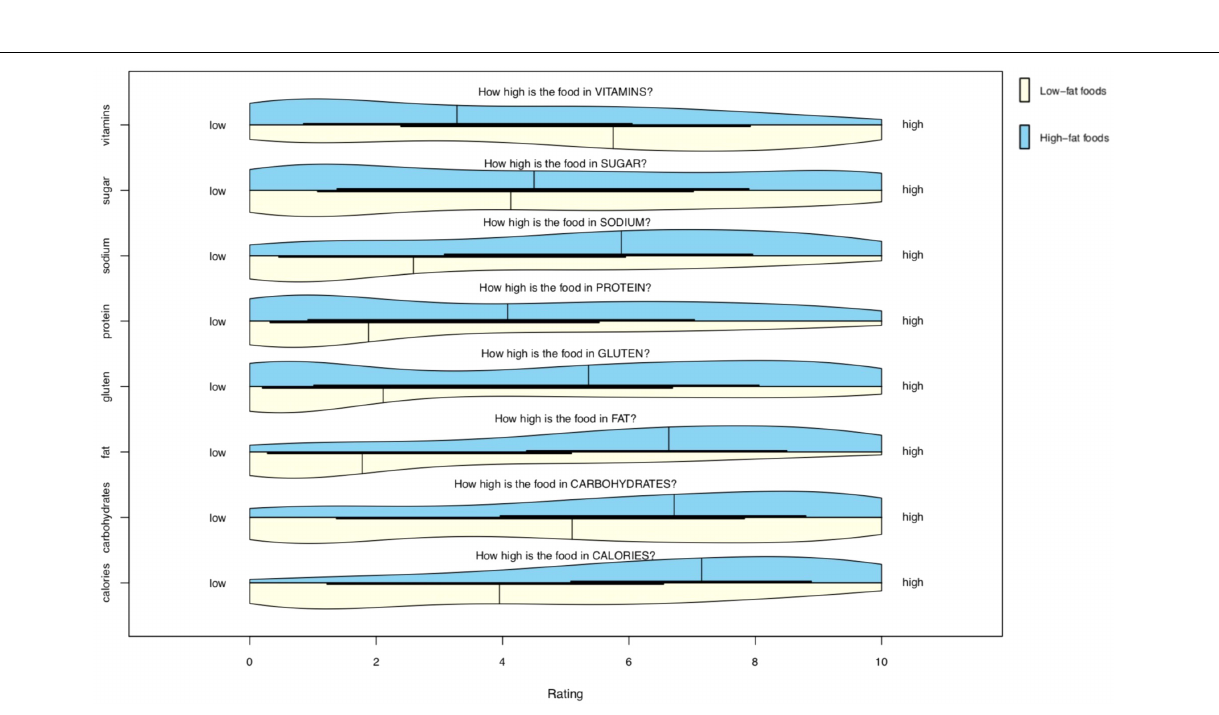
Frontiers in Psychology |